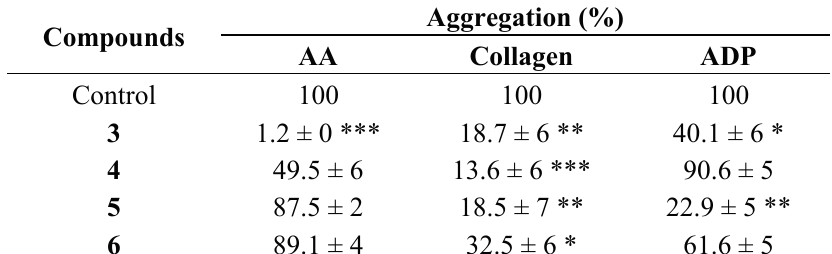
Table 2. Effects of compounds 3 , 4 , 5 and 6 on human platelet